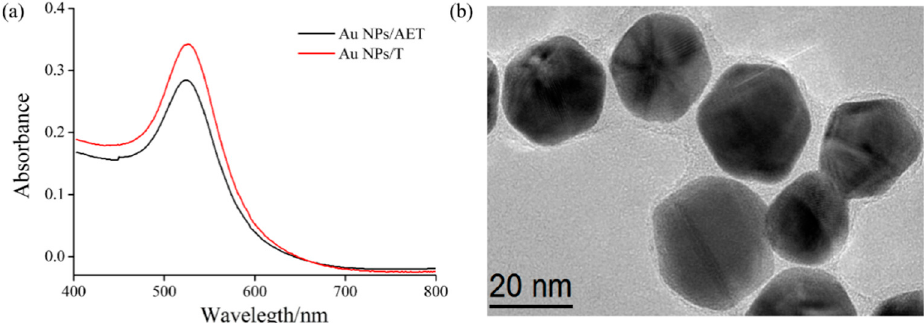
Figure 4. The characterization of Au NPs: ( a ) UV–vis absorption of Au NPs/AET and Au NPs/T; ( b ) TEM image of Au NPs/T.